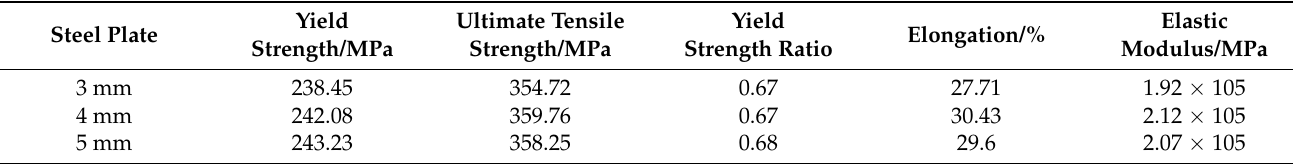
Figure 3. Drawing of standard tensile specimen (unit: mm). Table 2. Measurement results of the steel plates.